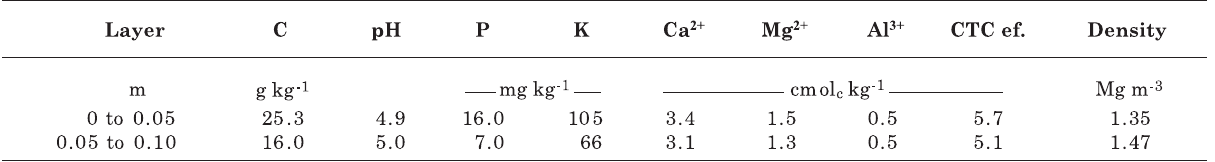
Table 1. Soil attributes in a Gleysol at the beginning of the